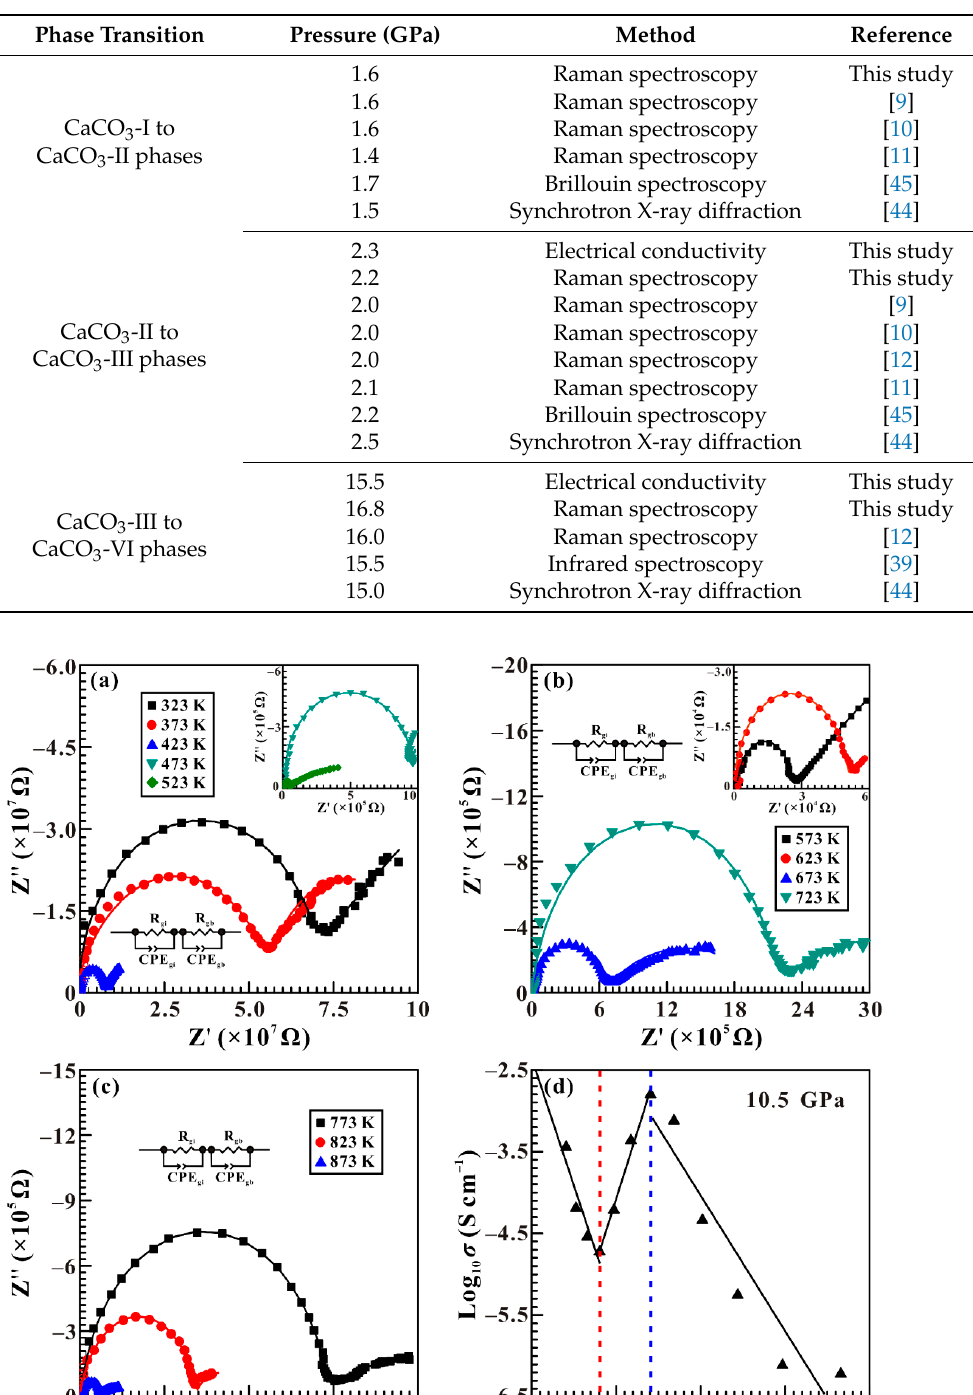
Table 3. Pressure-induced structural transition phases in calcite between CaCO 3 -I and CaCO 3 -II phases, CaCO 3 -II and CaCO 3 -III phases, and CaCO 3 -III and CaCO 3 -VI phases at atmospheric condition.